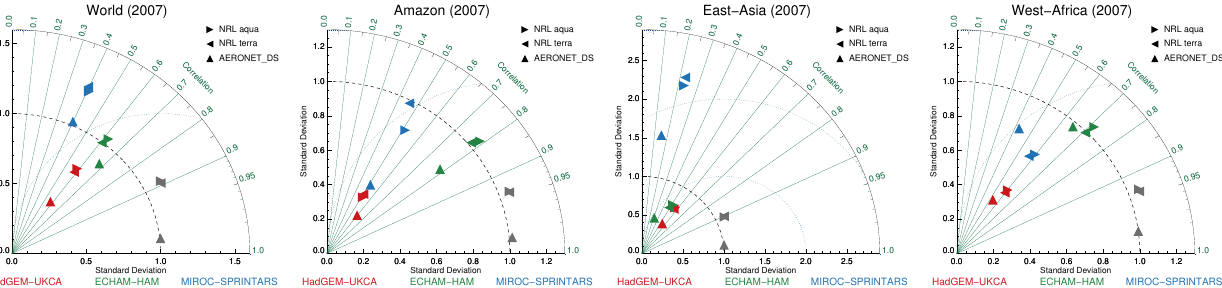
Figure 5. Taylor plots showing the standard deviation and correlation of modelled AOT against MODIS-NRL and AERONET observations. The dark grey symbols refer to observations randomly perturbed with estimated observational